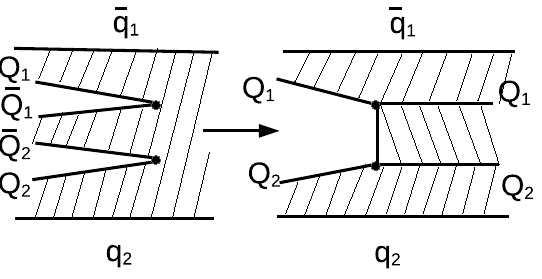
Figure 1 . The transition of the mesons ( q 1 ¯ q 2 ) + ( q 3 ¯ q 4 ) confining strings.